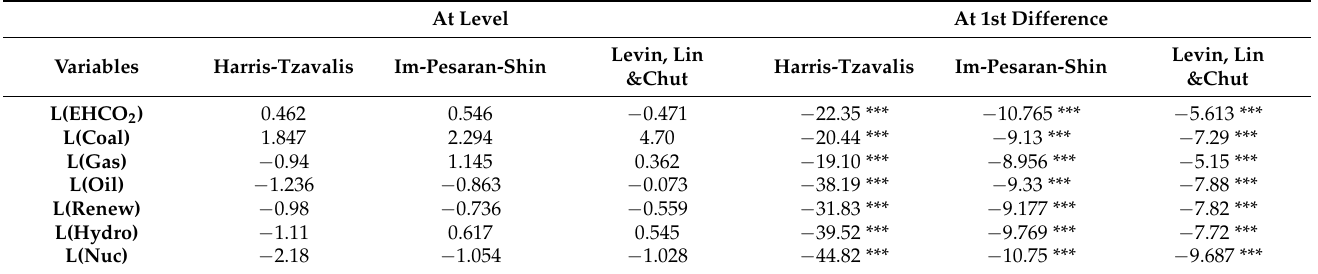
Table 3. Unit Root Test Result.